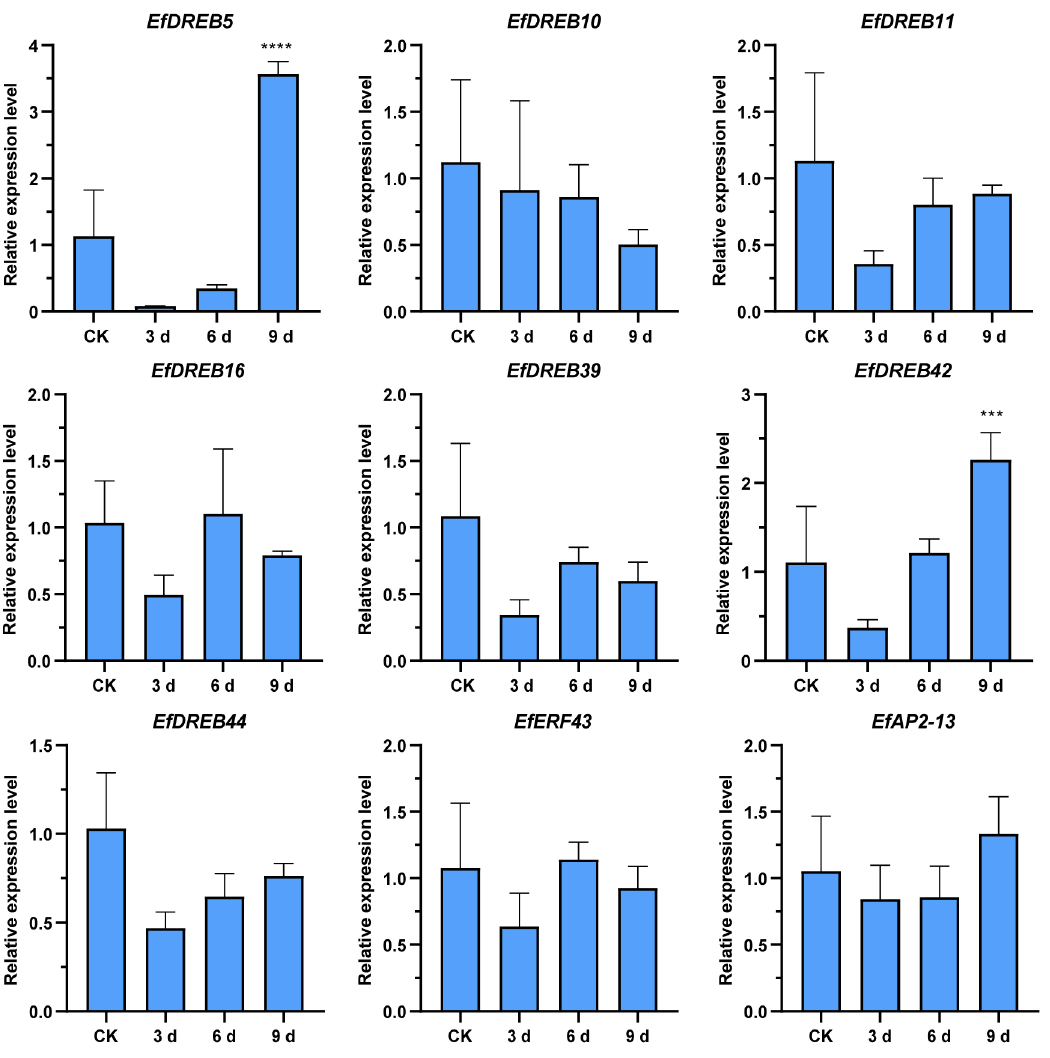
Figure 12. Expression profiles of 9 selected EfAP2/ERF genes in response to drought stress. Each column represents the mean of three independent experiments. The error bars represent the standard deviations of the mean. The significant differences relative to controls (one-way ANOVA with Tukey’s multiple range test) are indicated by *** p < 0.001, and **** p <